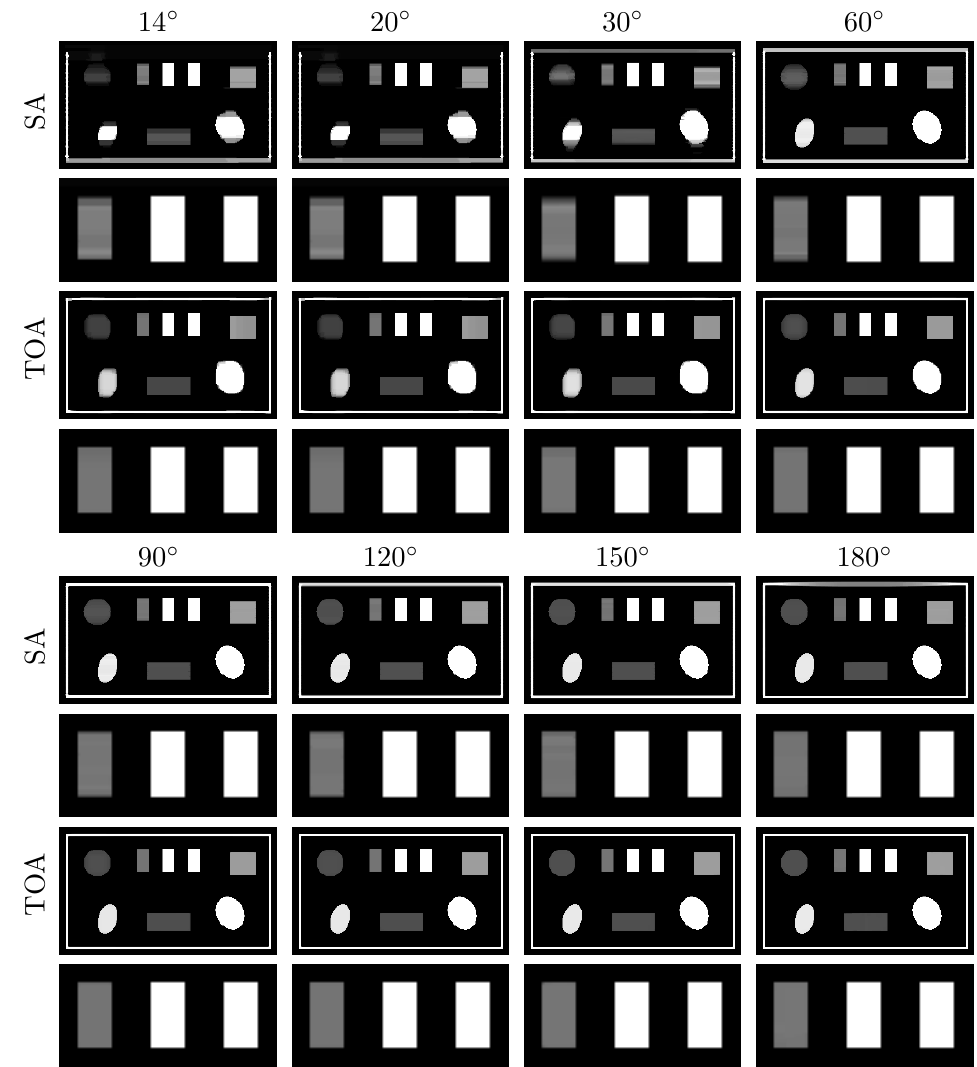
Figure 12. VMIs (rows 1, 3, 5, and 7), along with their respective zoomed-in views (rows 2, 4, 6, and 8), of the suitcase phantom at 40 keV obtained from noisy data acquired over SAs (rows 1&2 and 5&6) and TOAs (rows 3&4 and 7&8) of LAR 14 ◦ , 20 ◦ , 30 ◦ , 60 ◦ , 90 ◦ , 120 ◦ , 150 ◦ , and 180 ◦ , respectively, by use of the two-step method. Display window: [0.1, 0.65] cm − 1